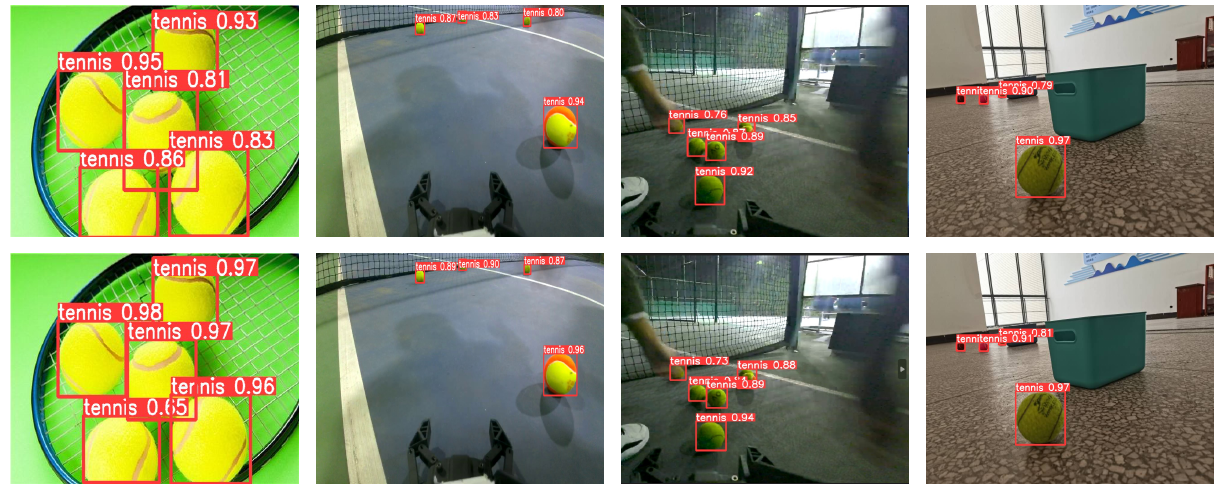
Figure 10. Comparison chart of test